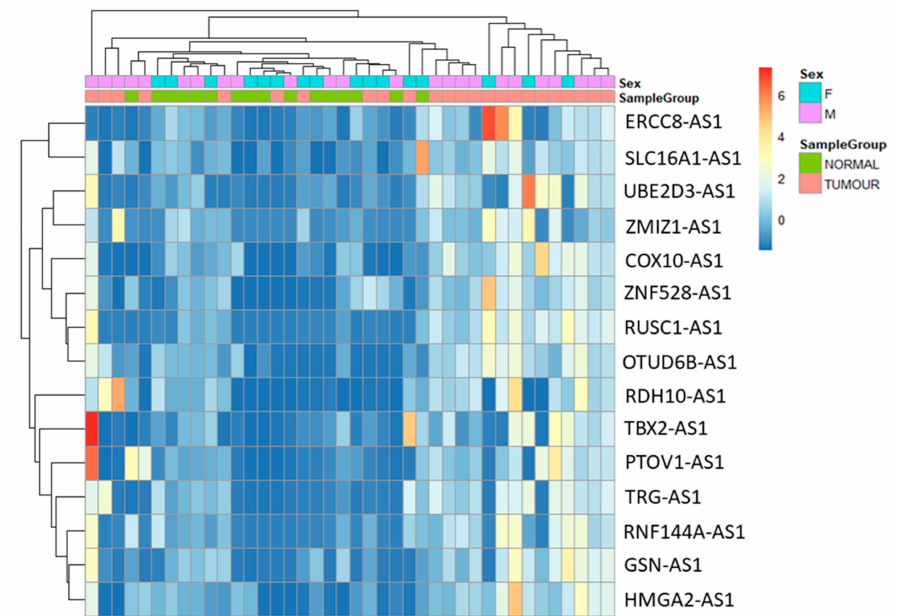
Figure 3. Heatmap of antisense lncRNAs expression comparison between the tumour (orange) and normal (green) samples.